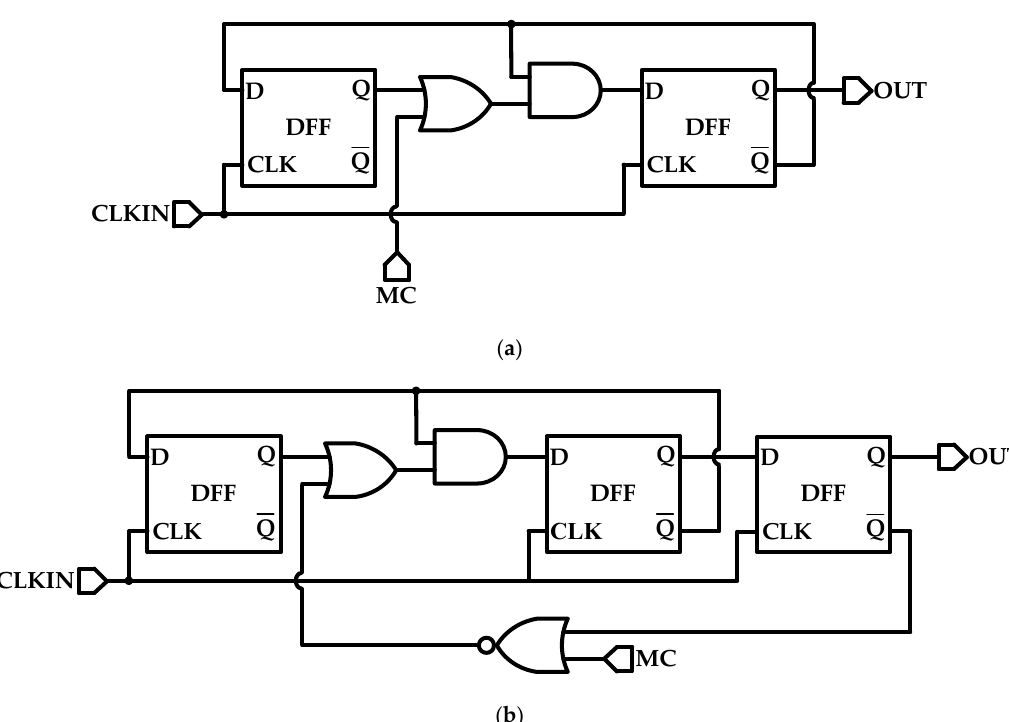
Figure 4. ( a ) Block diagram of the2 / 3 prescaler; ( b ) Block diagram of 4 / 5 prescaler.